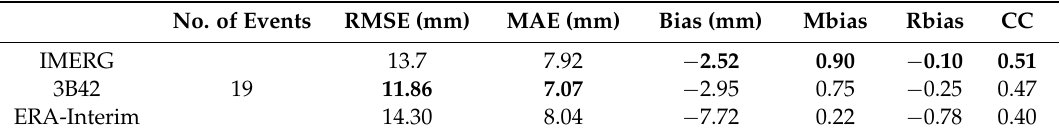
Table 7. Statistical indices of daily precipitation events in Tehran area (mid-March 2014 to February 2015).